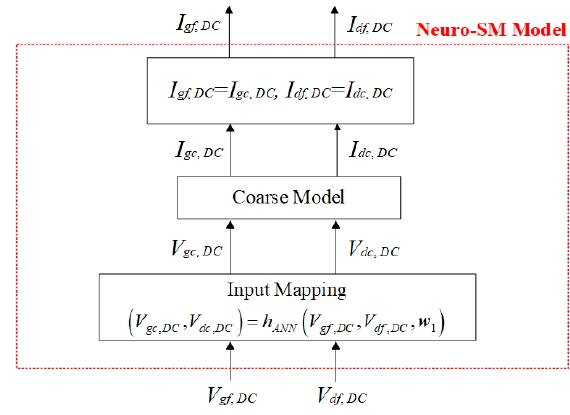
Figure 2. Schematic of the analytical DC model.